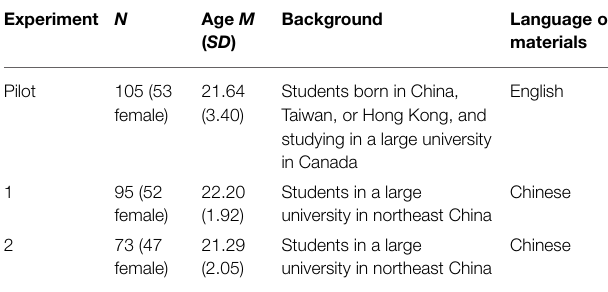
TABLE 1 | Sample characteristics of all